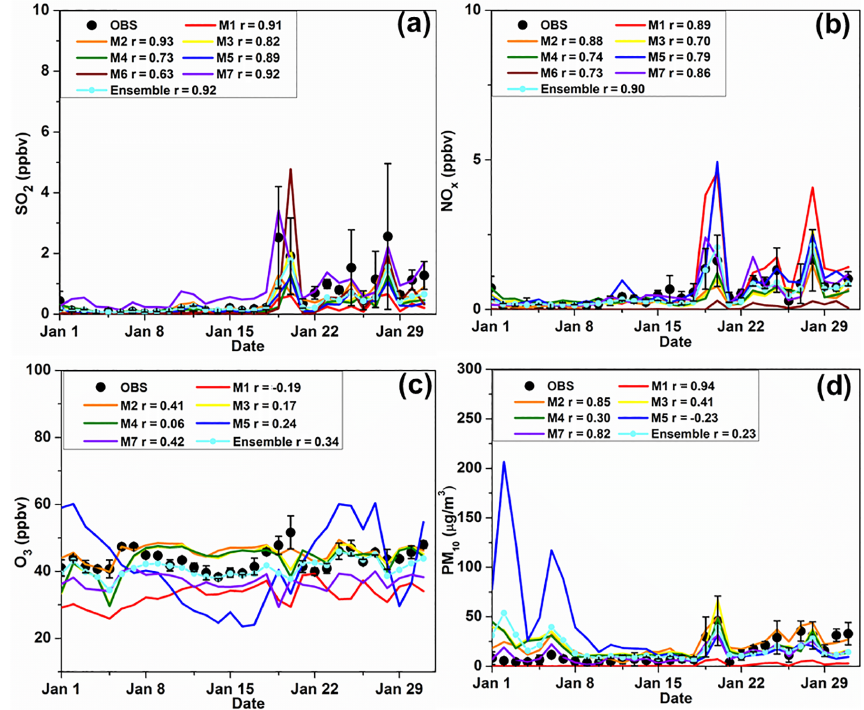
Figure 6. Comparisons between simulated and observed daily air pollutants (SO 2 , NO x , O 3 and PM 10 ) at the Rishiri EANET sites. Table 4. Performance statistics of air pollutants at the CARE-China sites (RMSE and MBE units: ppbv for gases and µgm − 3 for PM).